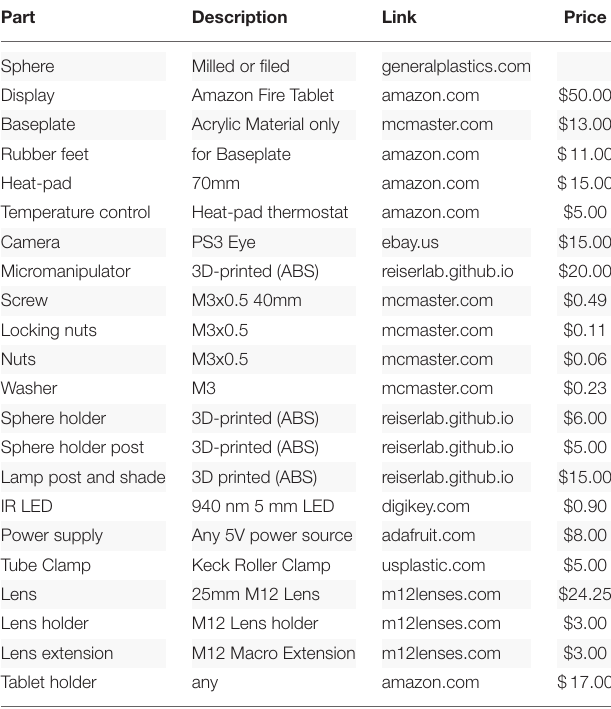
TABLE 1 | Price estimation of parts for experimental